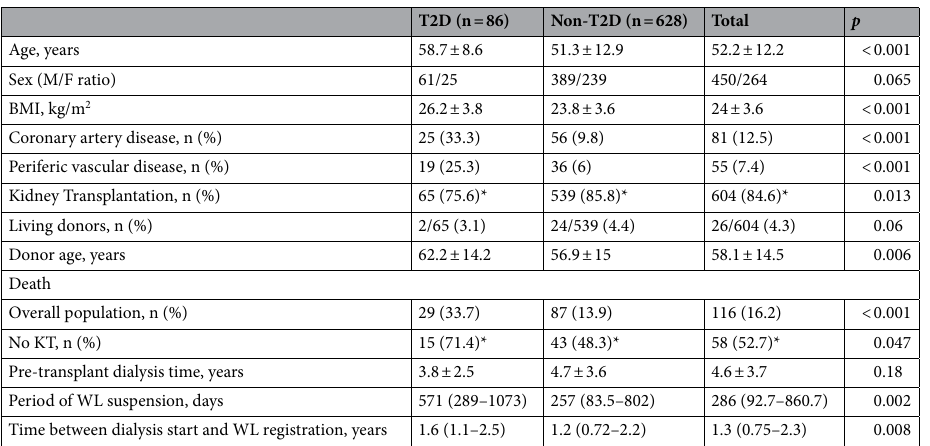
Table 1. Characteristics and follow-up of studied population according to T2D presence/absence. Data are expressed as mean ± SD or median (25°–75° percentile) according to their distribution. *Calculated on the total for each single group.